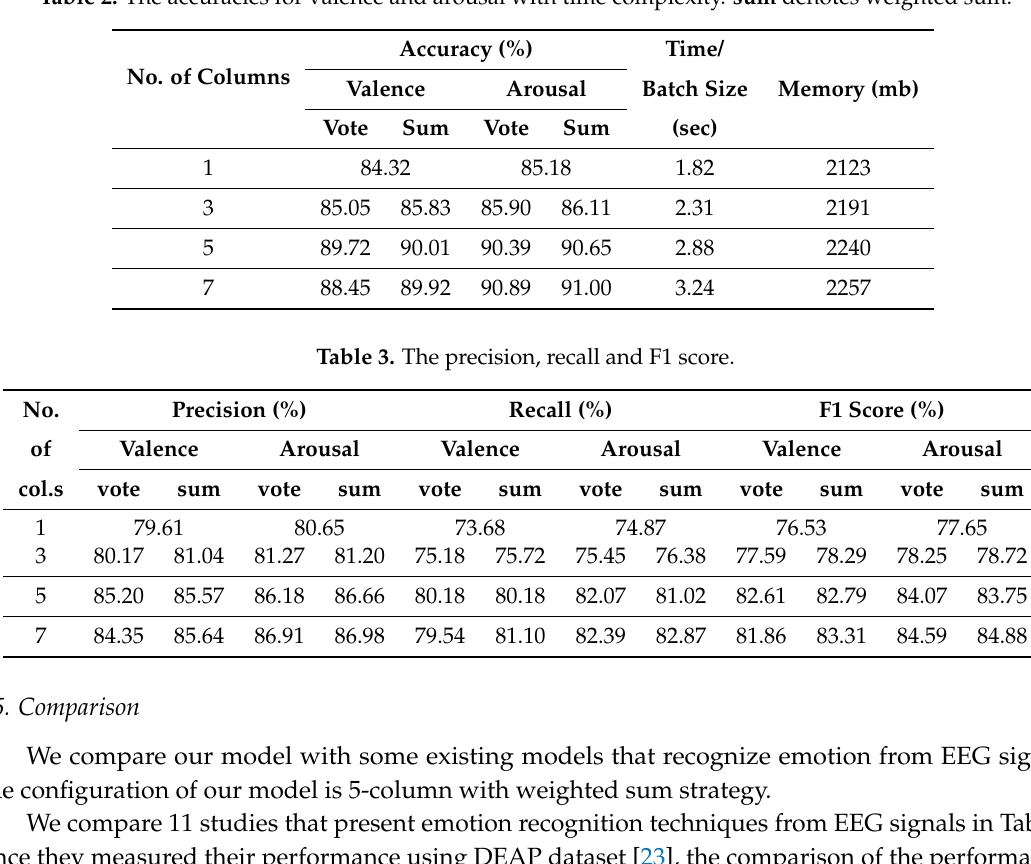
Table 2. The accuracies for valence and arousal with time complexity. sum denotes weighted sum.